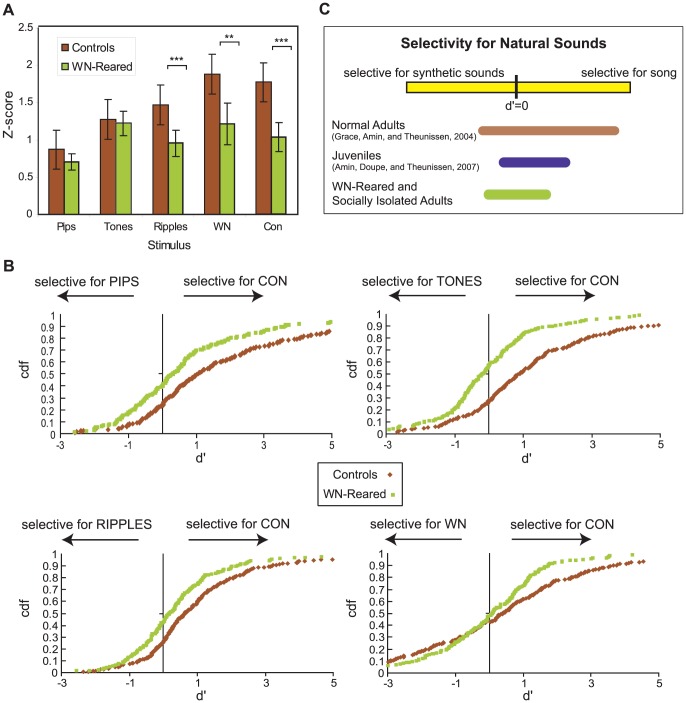
Neural responsivity and selectivity, as measured by z-scores and d′ values respectively.A. Comparison of control and wn-reared mean z-scores for all the stimuli used in the selectivity analysis (Con, Pips, Tones, Ripples, and WN). Average z-scores for all stimulus-excited responsive units show that responses to the more complex stimuli of Con, Ripples, and WN are reduced in wn-reared birds compared to control birds. Error bars represent 2 SEs. B. Cumulative distribution functions (cdf) of d′ values for the Con-Pips, Con-Tones, Con-Ripples, and Con-WN comparisons for both controls and wn-reared adults. Selectivity analyses (and the resulting cumulative curves) show the greatest divergence in rearing conditions for the Con-Tones, followed by the Con-Pips and Con-Ripples comparisons. C. Working model of the development of the neural selectivity for natural sounds such as song (d′>0 for song as compared to synthetic sounds), as a function of development and natural rearing environments, in the auditory system of songbirds. The bars in this schematic summarize the distributions of d′ values obtained from our data from control adults, juveniles, and wn-reared and socially-isolated adults.